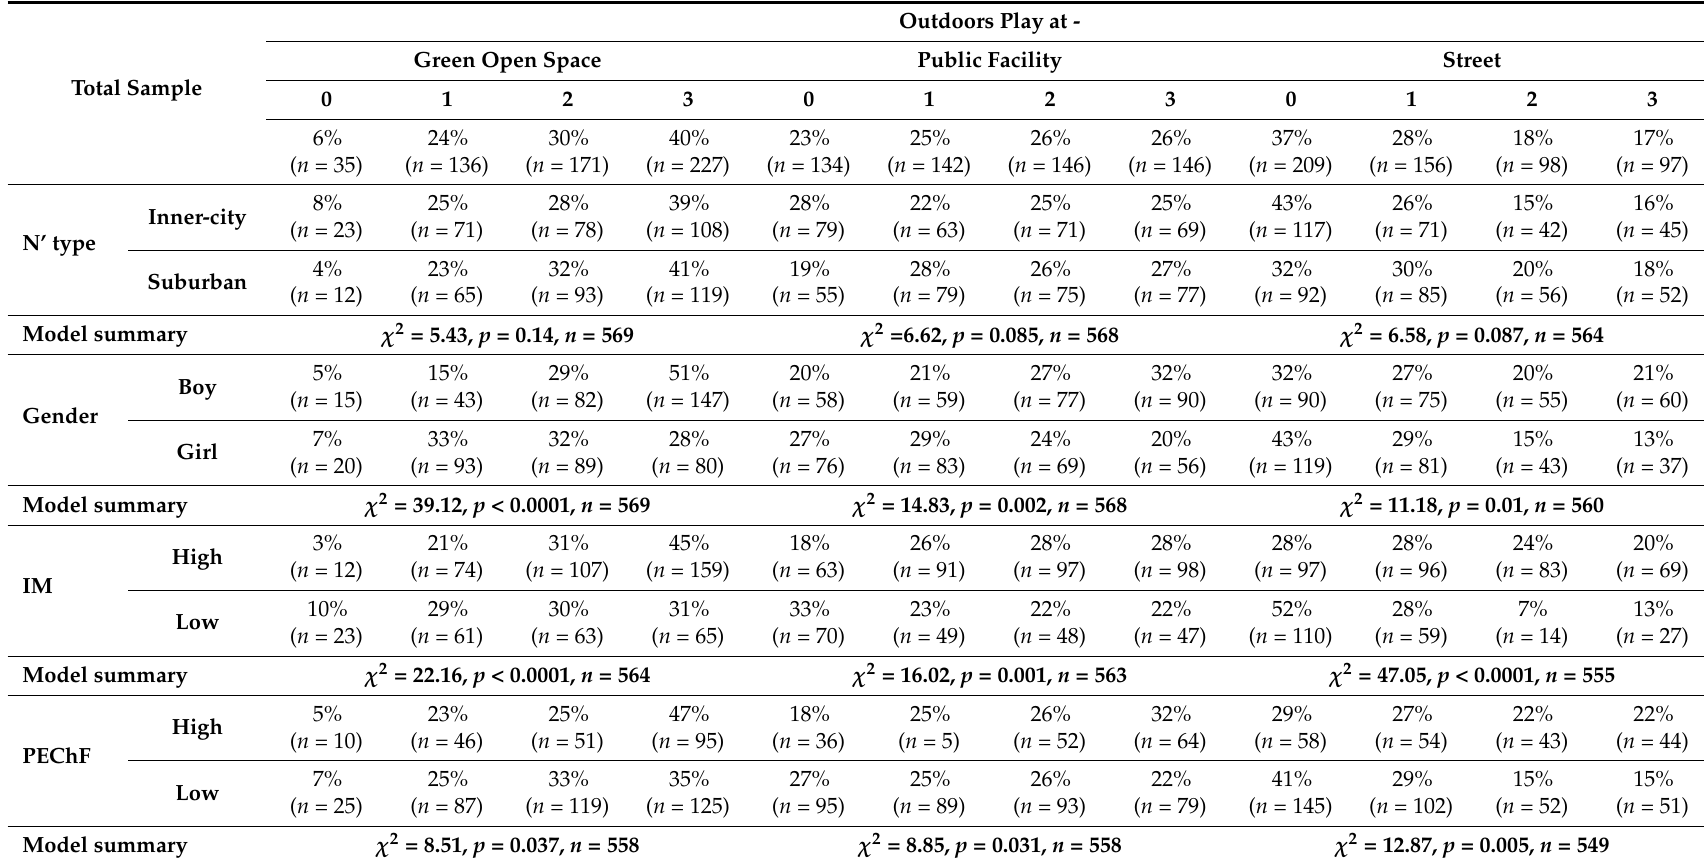
Table 2. Frequencies of outdoors play (OP) at different locations, by the research